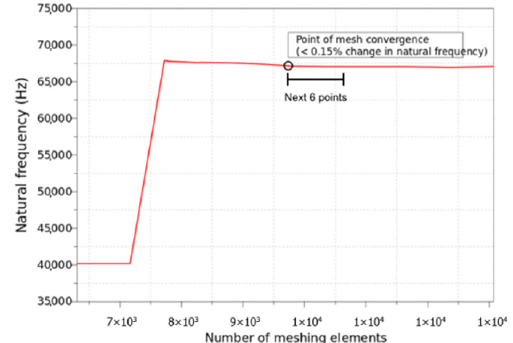
Figure 9. Linear vibratory MEMS gyroscope system-level model.